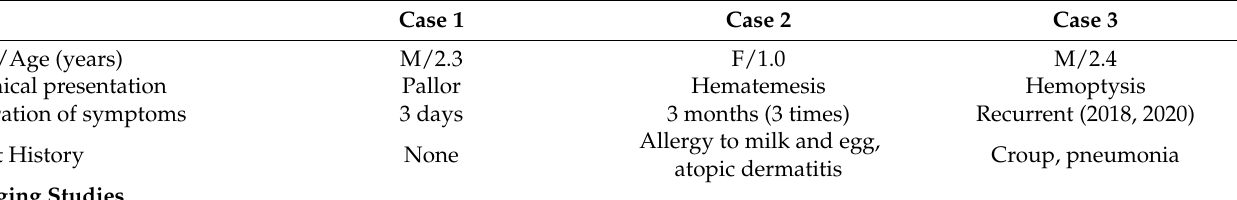
Table 1. Initial clinical characteristics of children with Heiner